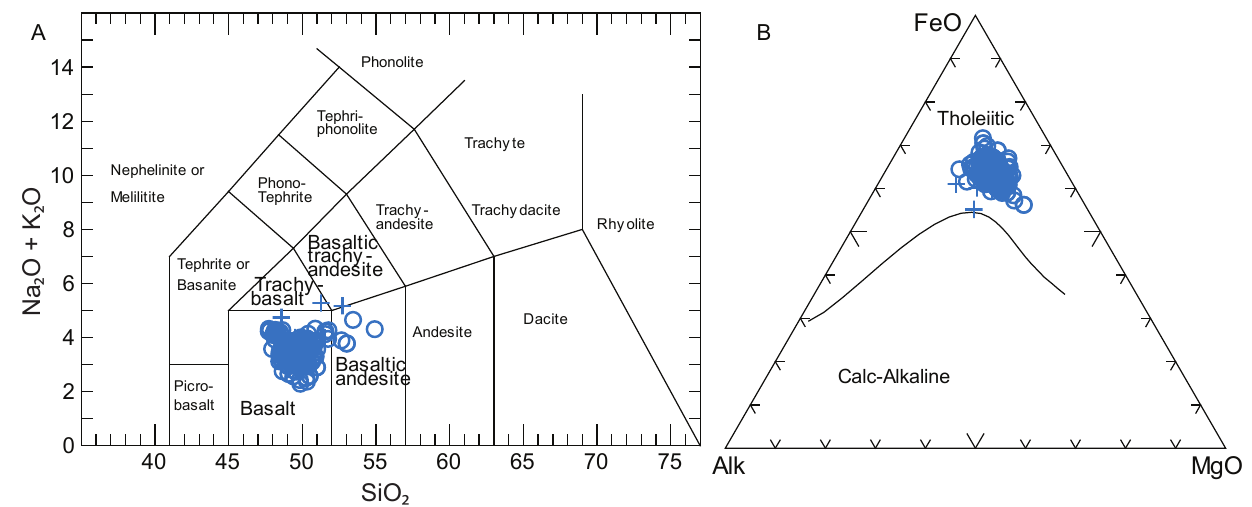
Figure 7: [A] Volatile-free total alkalis vs SiO 2 (TAS) diagram with the IUGS classification after Le Maitre et al. (1989). [B] Ternary AFM diagram plotting Alkalis (Na 2 O+K 2 O), FeO, and MgO. Tholeiitic and Calc-Alkaline boundary from Irvine and Baragar (1971). Both plots include all analyses, data in Table S1, Supplementary